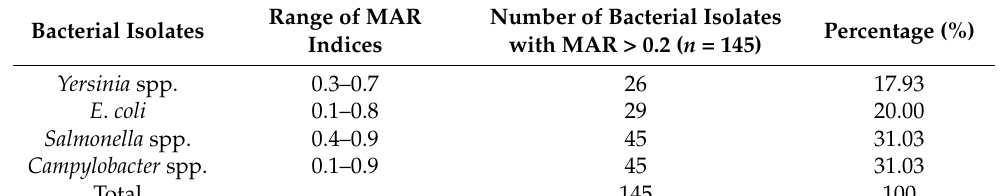
Table 2. Distribution of the bacterial isolates depending upon MAR > 0.2. Bacterial Isolates